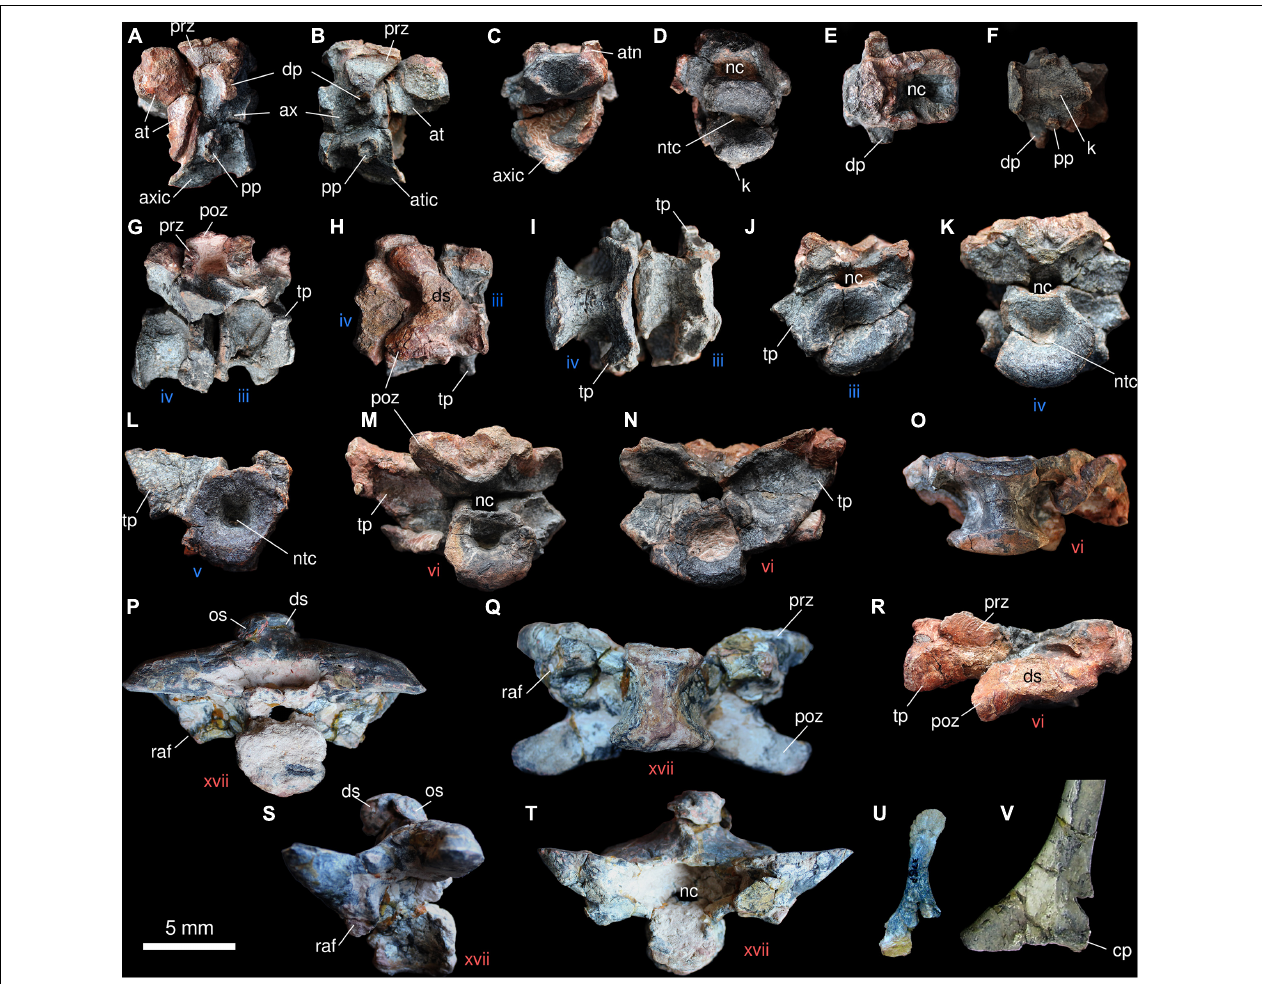
FIGURE 7 | Anterior axial skeleton of Provelosaurus americanus . (A–N,O,R) UFRGS-PV-0359-P; (P,Q,S,T,V) UFRGS-PV-0233-P. (U) UFRGS-PV-0376-P. Atlas and axis in (A) left lateral, (B) right lateral, (C) anterior, (D) posterior, (E) dorsal, and (F) ventral views. Third and fourth cervical vertebrae in (G) right lateral, (H) dorsal, (I) ventral, (J) anterior, and (K) posterior views. (L) Cervical vertebra in anterior view. First dorsal vertebra in (M) posterior, (N) anterior, (O) ventral, and (R) dorsal views. Posterior dorsal vertebra in (P) posterior, (Q) ventral, (S) left lateral and (T) anterior views. (U) Cervical rib, ?anterior view. (V) Right dorsal rib head in anterior view. at, atlas; atic, atlas intercentrum; atn, atlas neural arch; ax, axis; axic, axis intercentrum; cp, capitulum; dp, diapophysis; ds, dorsal spine; k, keel; nc, neural canal; ntc, notochordal canal; os, osteoderm; pp, parapophysis; poz, postzygapophysis; prz, prezygapophysis; raf, rib articular facet; tp, transverse process, iii–xvii, vertebrae numbers (blue, cervicals; red,